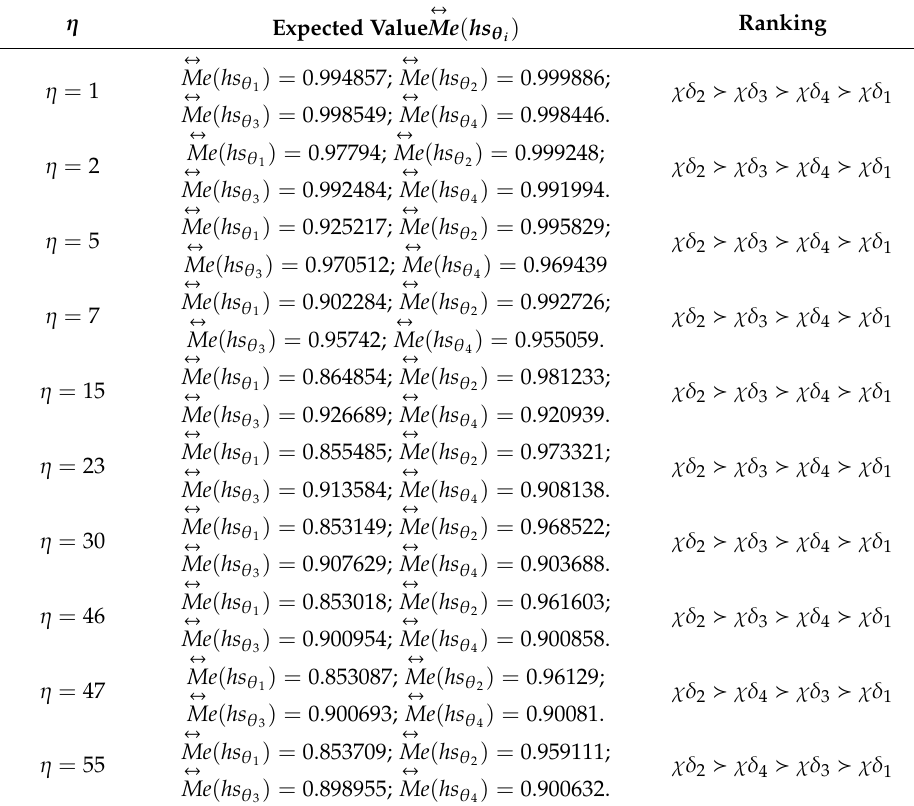
Table 5. The results under di ff erent values of